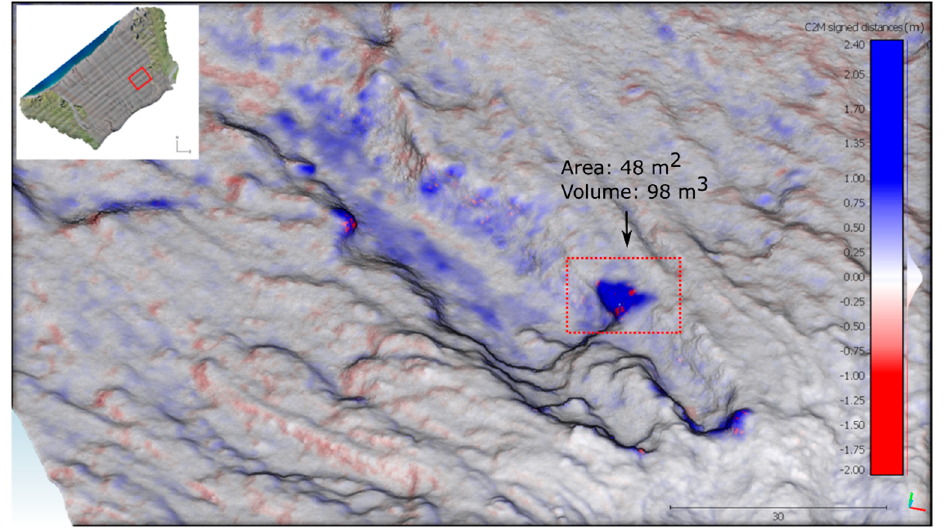
Figure 10. Stromboli 3–Stromboli 2 difference evaluated in a small area after the usage of the Iterative Closest Point (ICP) alignment tool. The analysis points out a small detachment area formed in the period that occurred between April 2017 and November 2017.